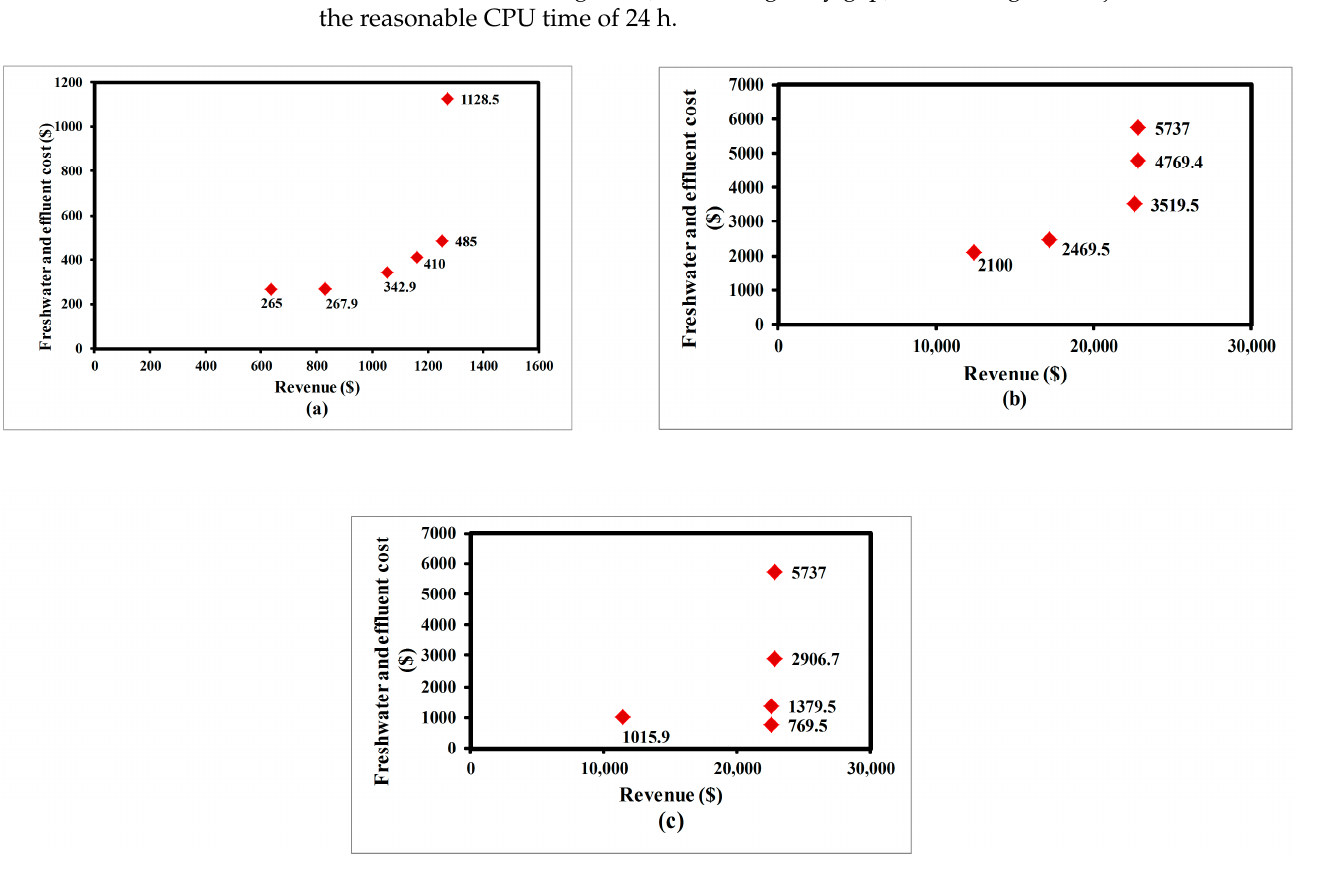
Figure 17. Pareto plots ( a – c ) for case studies 1, 2 and 3, for the two-objective